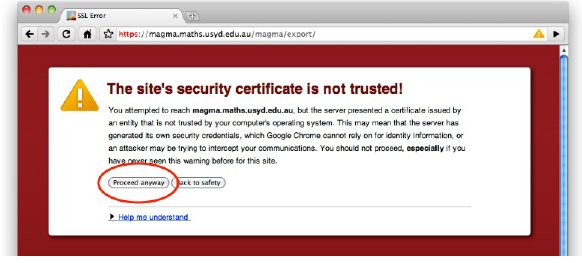
Figure 8-1: Security certificate